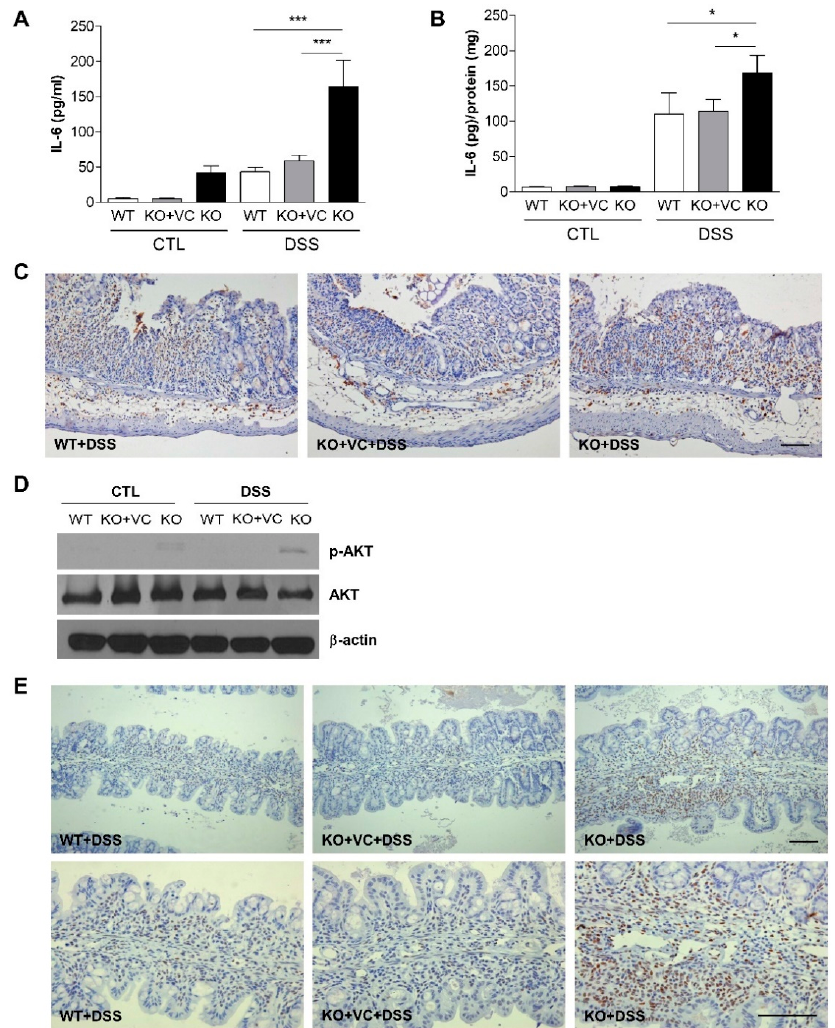
Figure 5. Vitamin C insufficiency and DSS treatment increase IL-6 production. Mice were treated with DSS for 7 days, and the level of IL-6 was measured in ( A ) plasma ( n = 15–18) and ( B ) colon homogenates ( n = 9–13) by ELISA. The final tissue IL-6 concentration was normalized to proteins in colonic homogenates. * p < 0.05, *** p < 0.001. ( C ) Infiltrated macrophages were stained with F4/80 antibodies. Scale bar, 100 μ m. ( D ) Akt phosphorylation was examined in colon lysates with im- munoblotting. The results are representative of three independent experiments. ( E ) Phosphorylated STAT3 in the colon was examined by immunohistochemistry. Scale bar, 100 μ m. Statistical analysis was performed using the Tukey multiple comparisons test after one-way ANOVA.